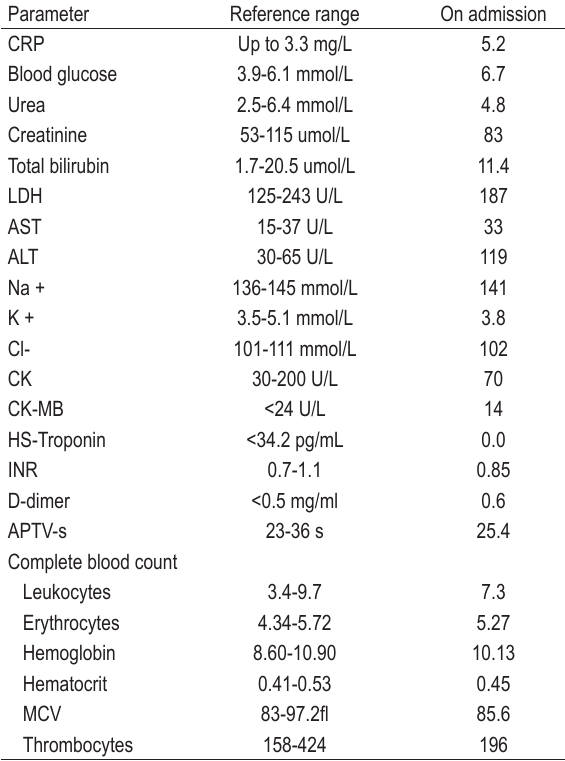
TABLE 1. Laboratory findings at admission, January 2021